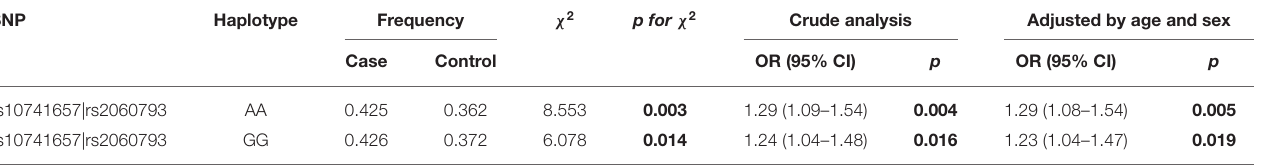
TABLE 6 | Haplotype frequencies in CYP2R1 and their associations with CHD risk. SNP Haplotype